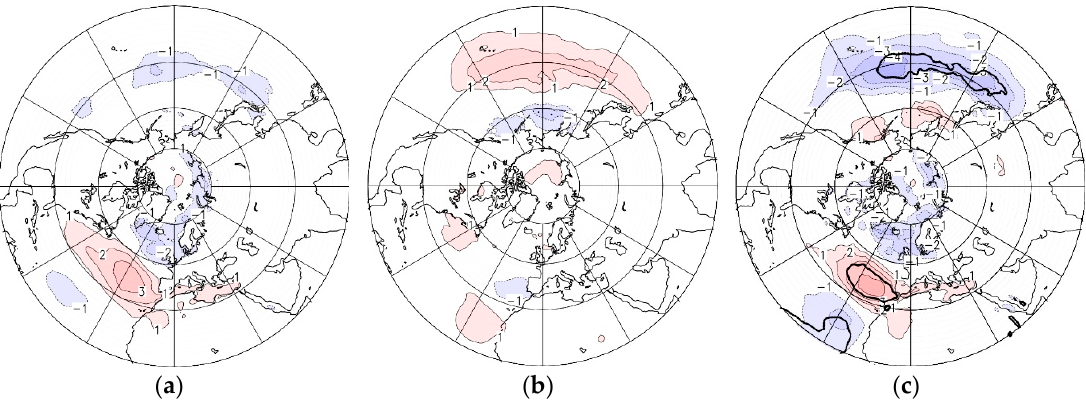
Figure 9 . Mean 10 m (above surface) zonal wind anomaly (m/s) for strong ‐ PJO events ( a ), non ‐ PJO events ( b ), and difference of strong ‐ PJO minus non ‐ PJO events ( c ) for ERA ‐ Interim during 15 days after CD. Thick black (green) line in ( c ) includes areas of significant differences with student’s t ‐ test of 80% (90%) confidence.